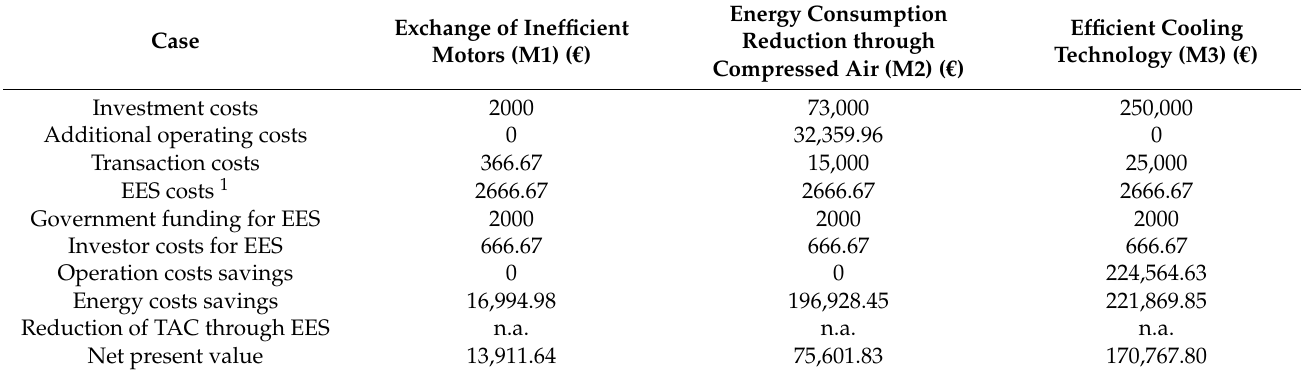
Table 2. Present value costs and benefits of selected energy efficiency measures over the respective life time using a 2.00% discount